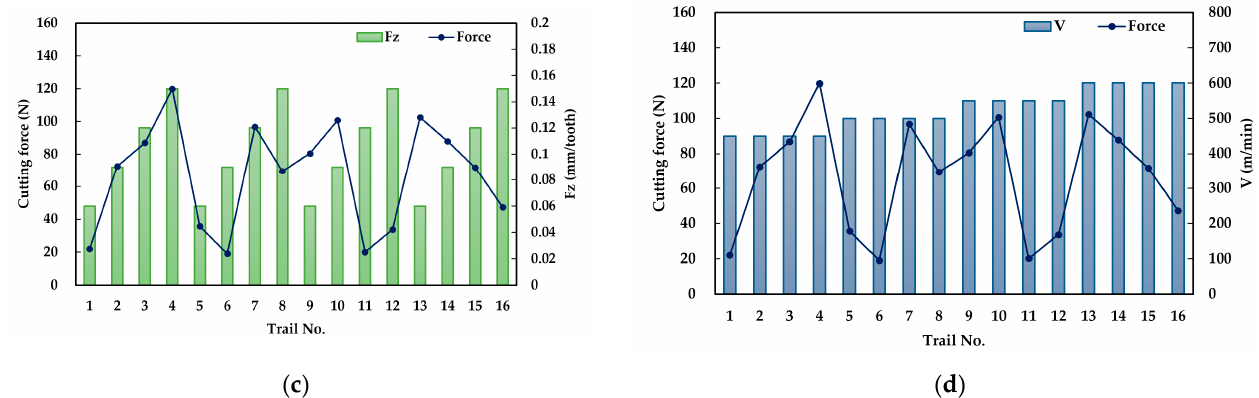
Figure 13. The impact of cutting parameters on the cutting force: ( a ) Ap (mm), ( b ) Ae (mm), ( c ) fz (feed/tooth), and ( d ) V (m/min).